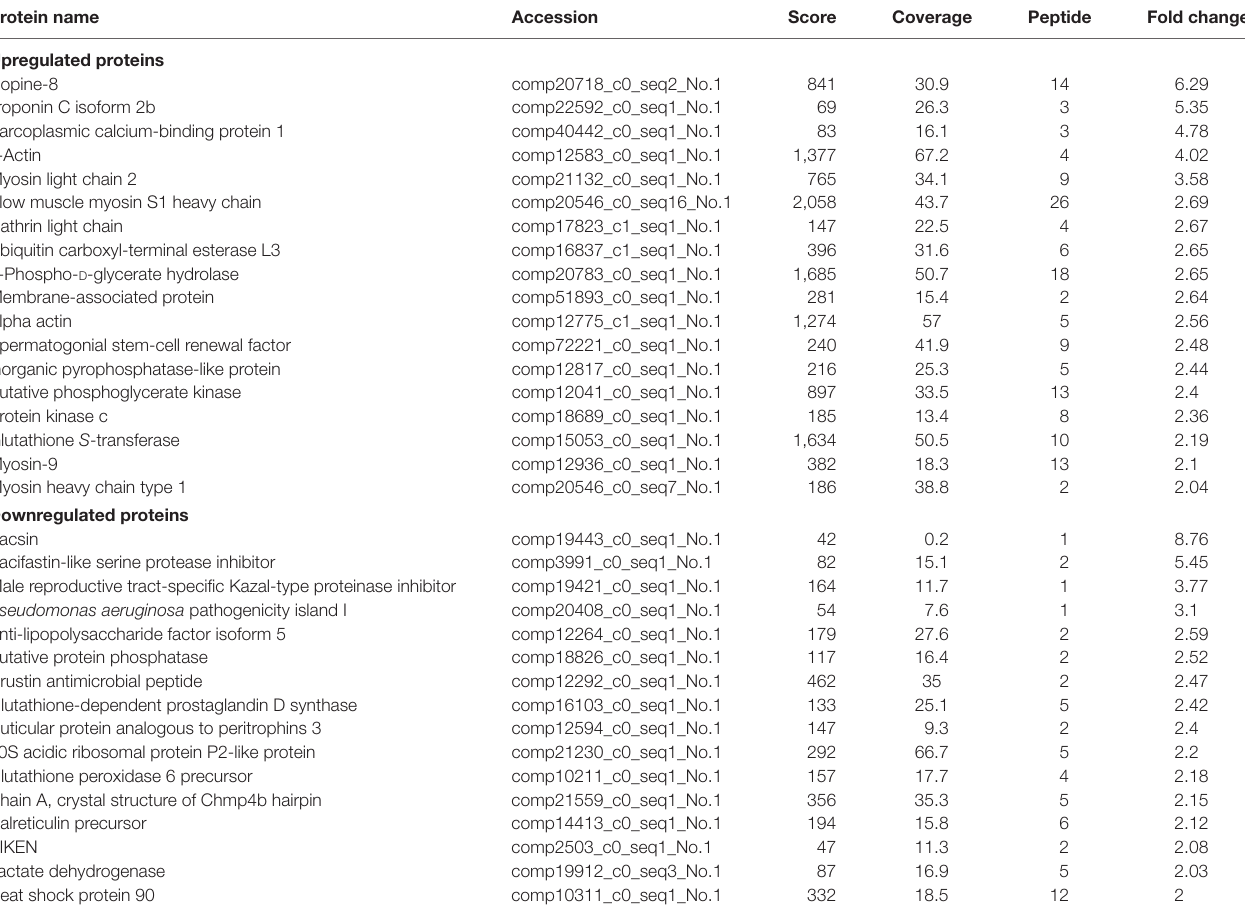
TaBle 1 | The differential expressed proteins in Scylla paramamosain hemocytes with above two-fold change post injection with white spot syndrome virus.